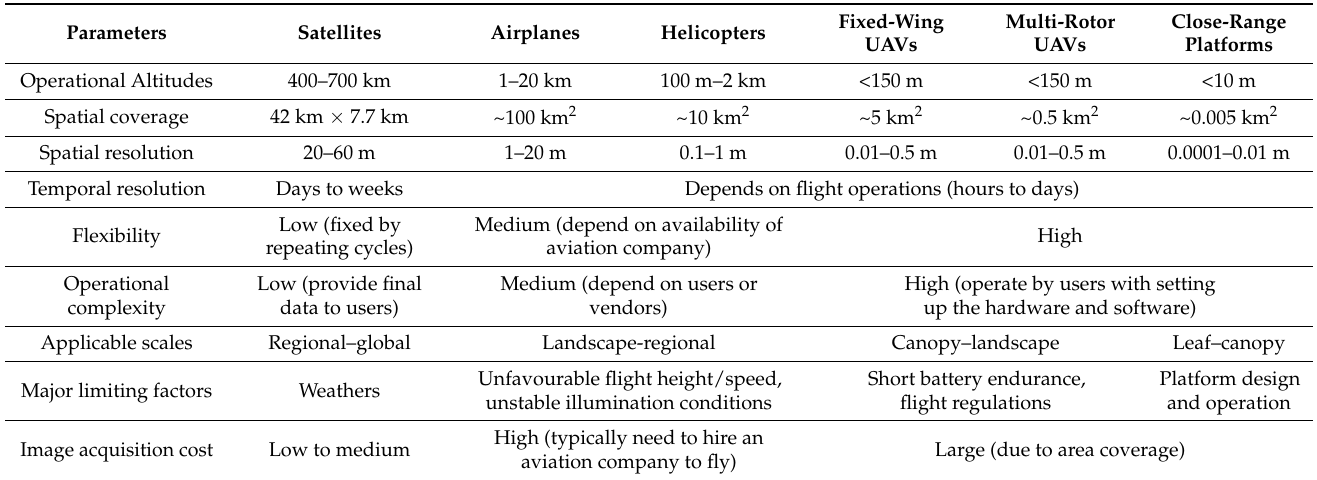
Figure 1. Hyperspectral data cube structure [34,35]. Table 3. Comparison of hyperspectral imaging platforms